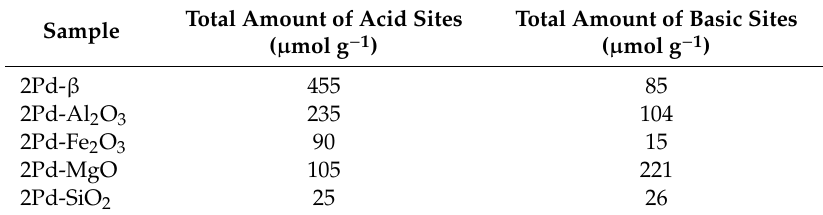
Table 3. XPS data of Pd-based catalysts (Pd content: 2 wt.%). Sample